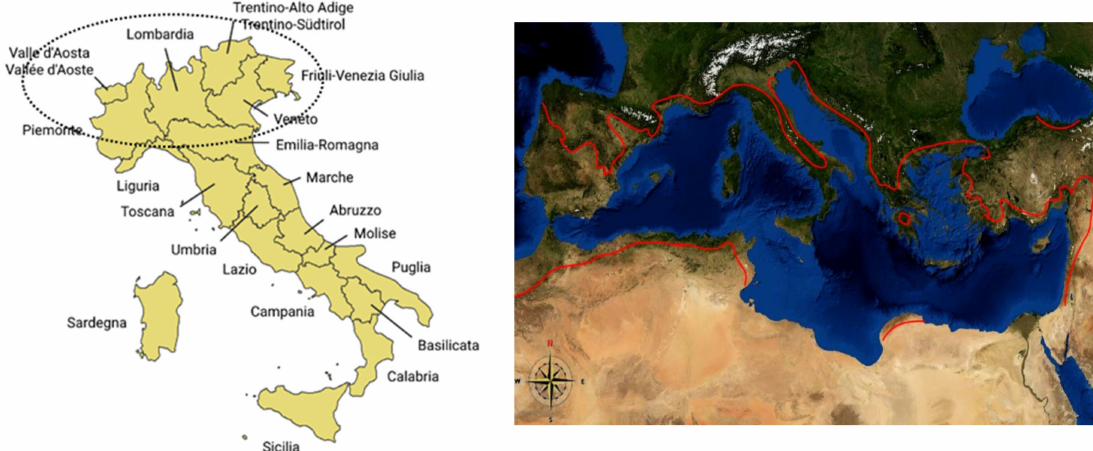
Figure 1. ( left ) A map of Italy with boundaries of the administrative regions. The dotted line indicates the study area in Northern Italy. ( right ) A general map of the Mediterranean Basin illustrating the geographical range of the olive